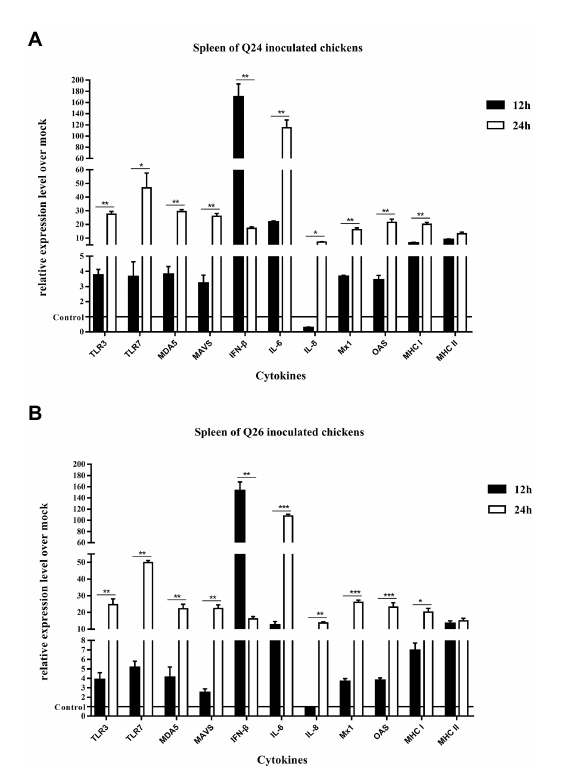
FIGURE 11 The expressions of immune-relate genes in the spleen of inoculated chickens. Comparing of the expressions of TLR3, TLR7, MDA5, MAVS, IFN- β , IL-6, IL-8, Mx1, OAS, MHC I, and MHC II in the spleen harvested from the inoculated chickens by (A) Q24 and (B) Q26 H7N9 AIVs at 12 and 24 HPI, respectively. They were tested using the quantitative RT- PCR and calculated as follows: fold change = 2 - △△ Ct , which △ = Ct target-Ct β -action, and △△ Ct = △ Ct treated- △ Ct control. Therefore, the expressions of all of the cytokines in the health control chickens were 1. We carried out the Student’s t -test between the experimental groups at 12 and 24 HPI, p < 0.05 was identified statistically significant (* p < 0.05; ** p < 0.01; *** p <